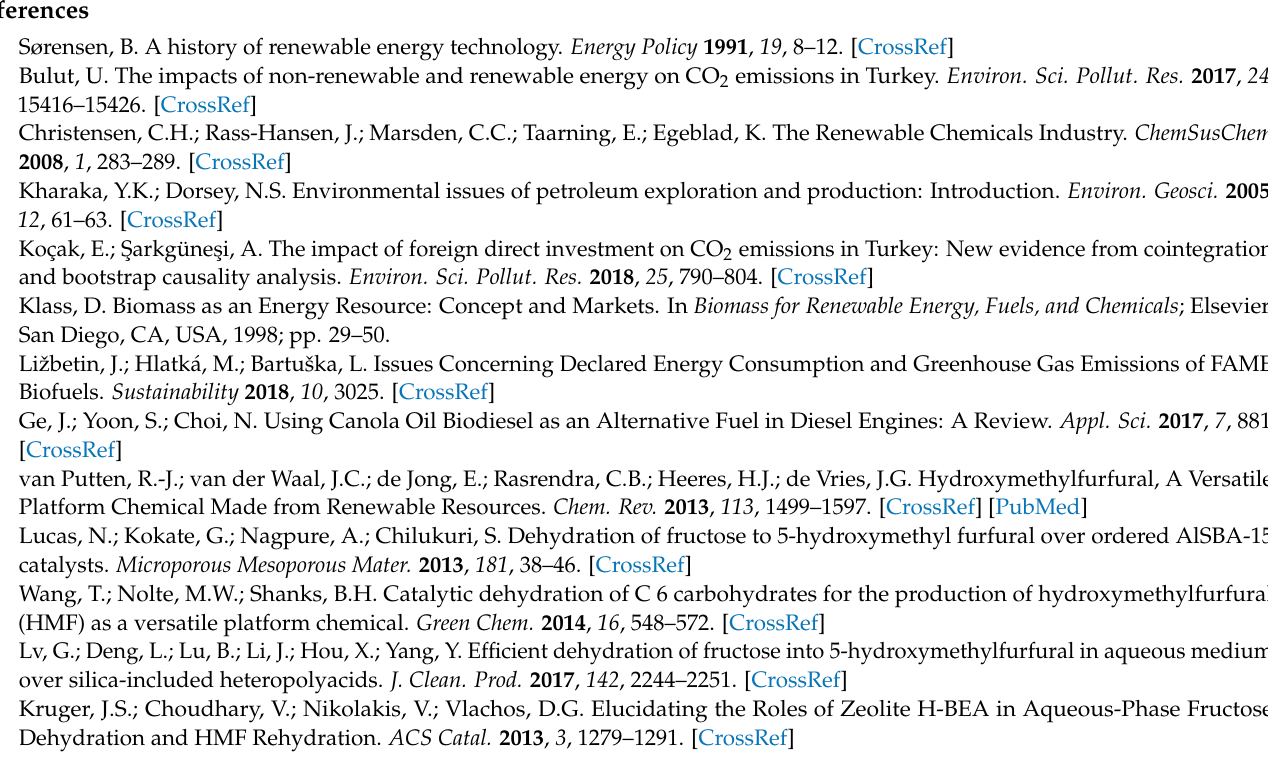
Figure S2: XRD patterns of the aluminosilicates, Figure S3: FT-IR spectra of (A) crystalline alumi- nosilicates and (B) amorphous silica-alumina after adsorption of pyridine, Figure S4: Adsorption and desorption isotherms of N 2 at − 196 ◦ C of the